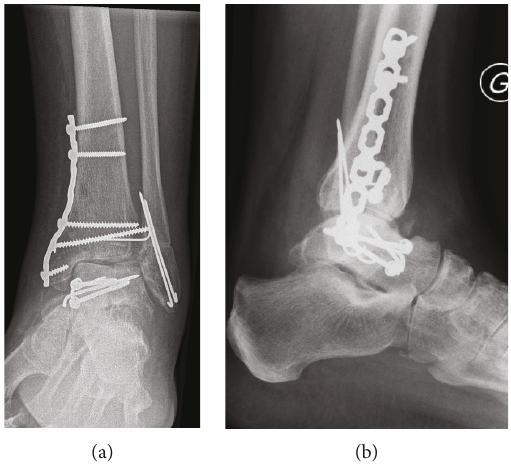
Figure 3: (a) AP and (b) lateral X-rays of the left ankle at 6 months, showing consolidated fractures and an anatomical reconstruction, with the absence of necrosis of the